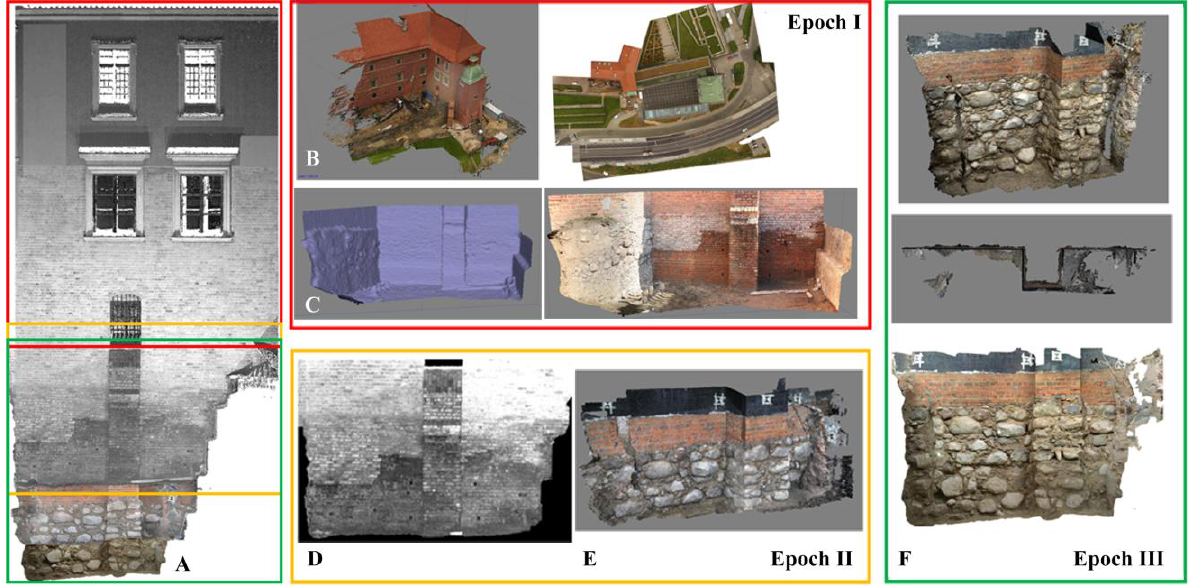
Figure 4. Results of integration of multitemporal data: A) the combined multitemporal image, B) the 3D model 3D and true- orthophoto from the DJI Phantom 3 Pro (Epoch I), C) the 3D model and the RGB orthoimage for the upper part of the excavation (Epoch I), D) the intensity orthoimage from TLS Z+F 5006h, and E) the 3D model from images of the central part of the excavation (Epoch II), F) the 3D model and the RGB orthoimage for the bottom part of the excavation (Epoch